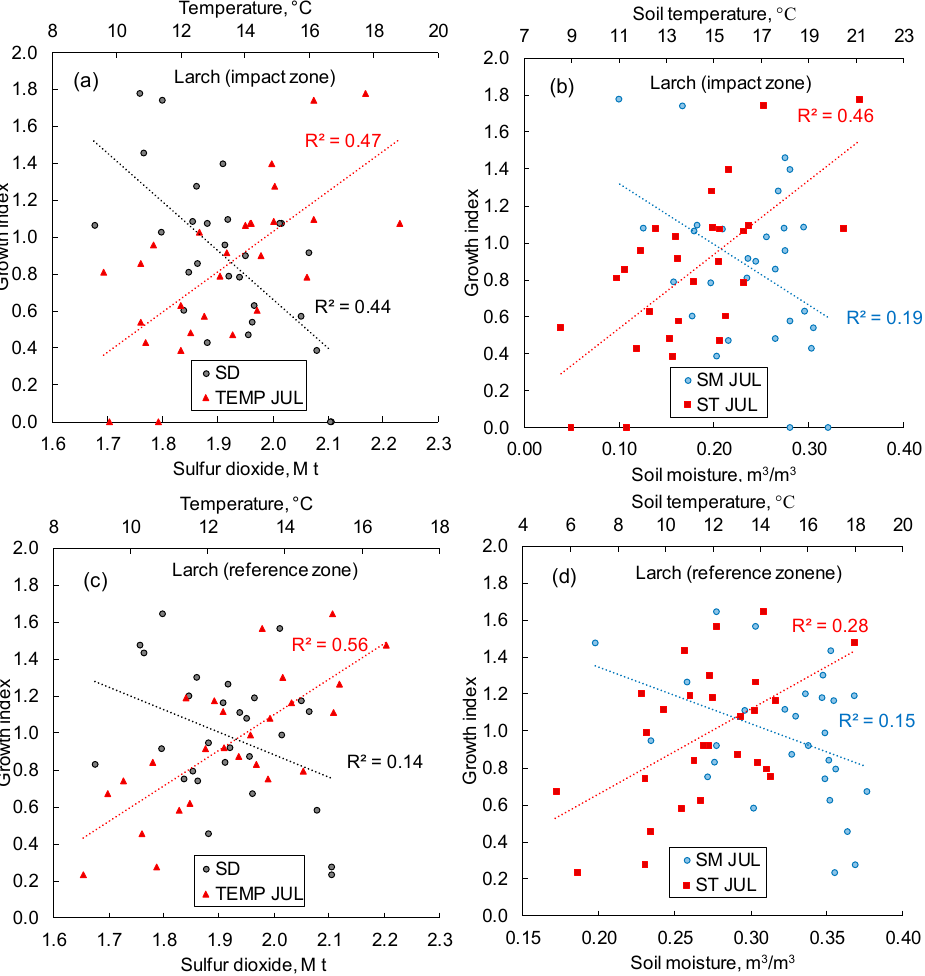
Figure 9. In the impact zone ( a , b ), larch growth increases with air and soil temperatures increase, and decreases with soil moisture and SO 2 emission increase. In the reference zone ( c , d ), similar correlations were observed, except for the GI–SO 2 correlation, which is insignificant. TEMP and ST—air and soil temperatures, SM—soil moisture, SD—sulfur dioxide emission, JUL—July. All trends are significant at p < 0.05, except for the GI–SO 2 trend ( c ). The study period is 1993–2021.